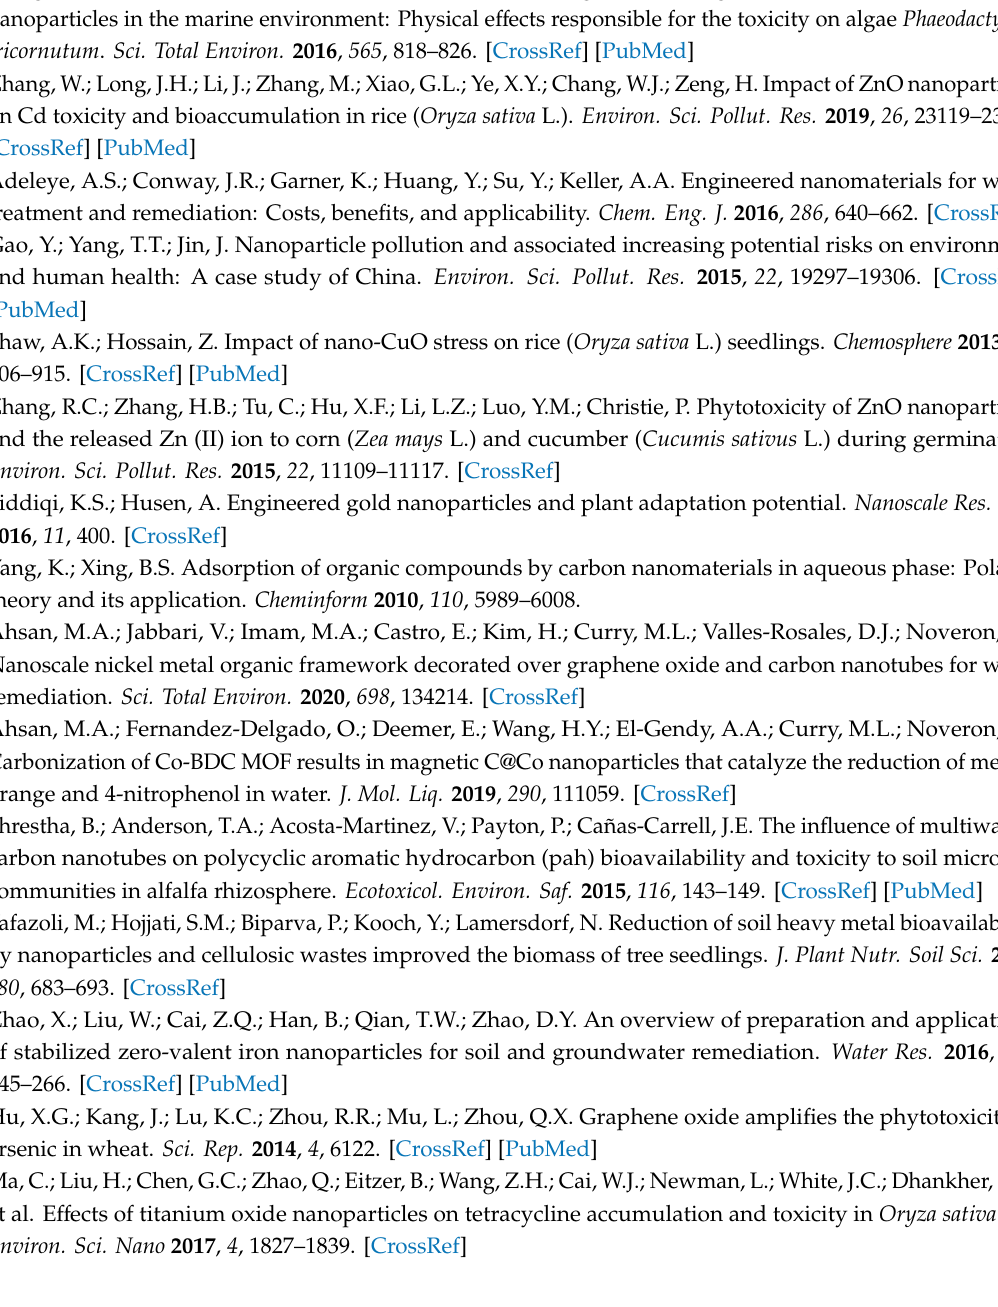
Table S1: Basic physicochemical properties of paddy soils, Table S2: The recovery of Cu and Zn in the soils with CuO-NPs and ZnO-NPs